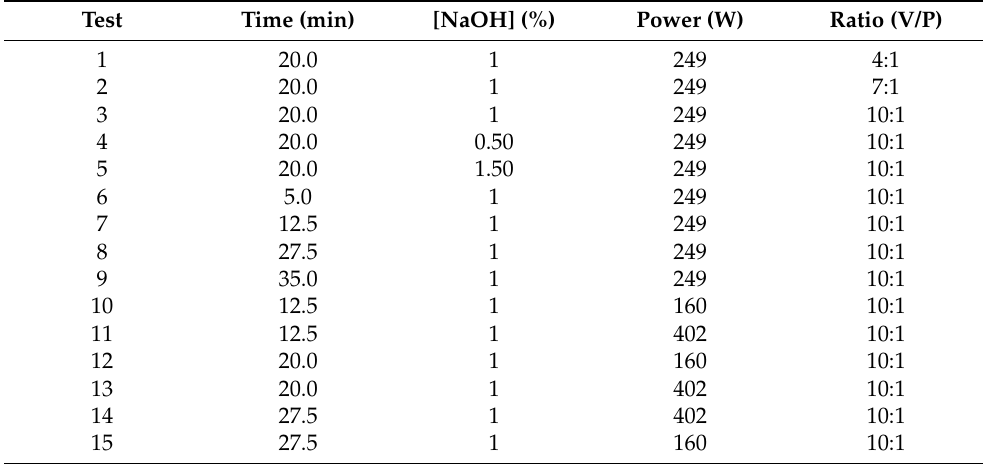
Table 2. Experimental conditions used on microwave